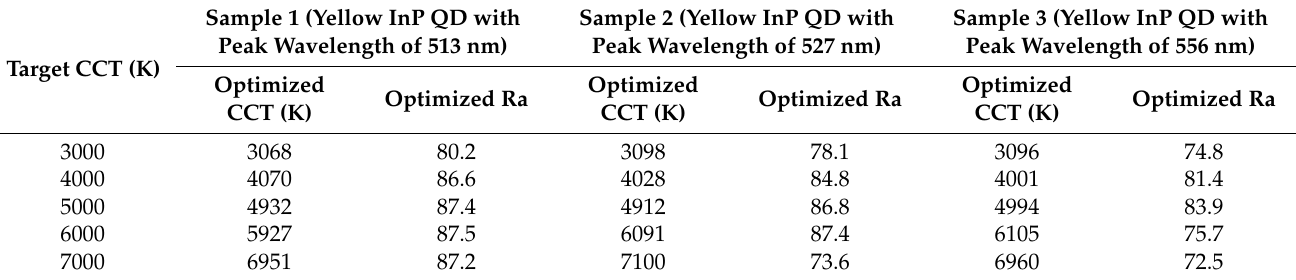
Table 1. Optimized CCT and Ra values of sample 1, 2, and 3 under various target CCT values. Sample 1 (Yellow InP QD Target CCT (K)